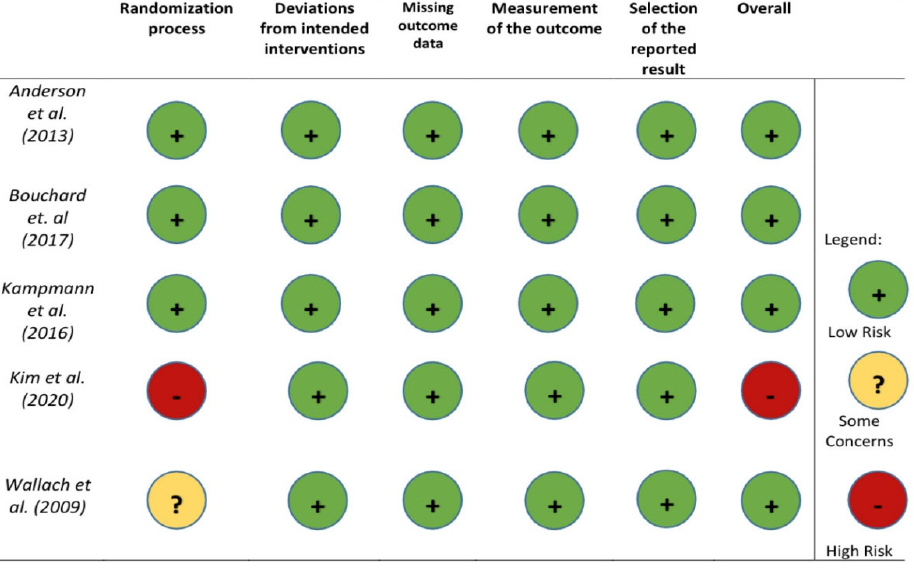
Figure 2. Cochrane risk ‐ of ‐ bias tool (RoB 2).